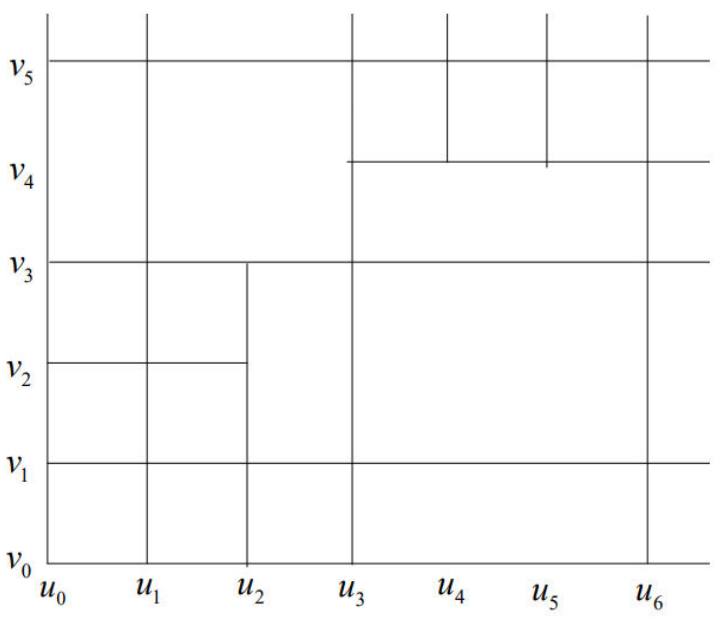
Figure 8. The third example.